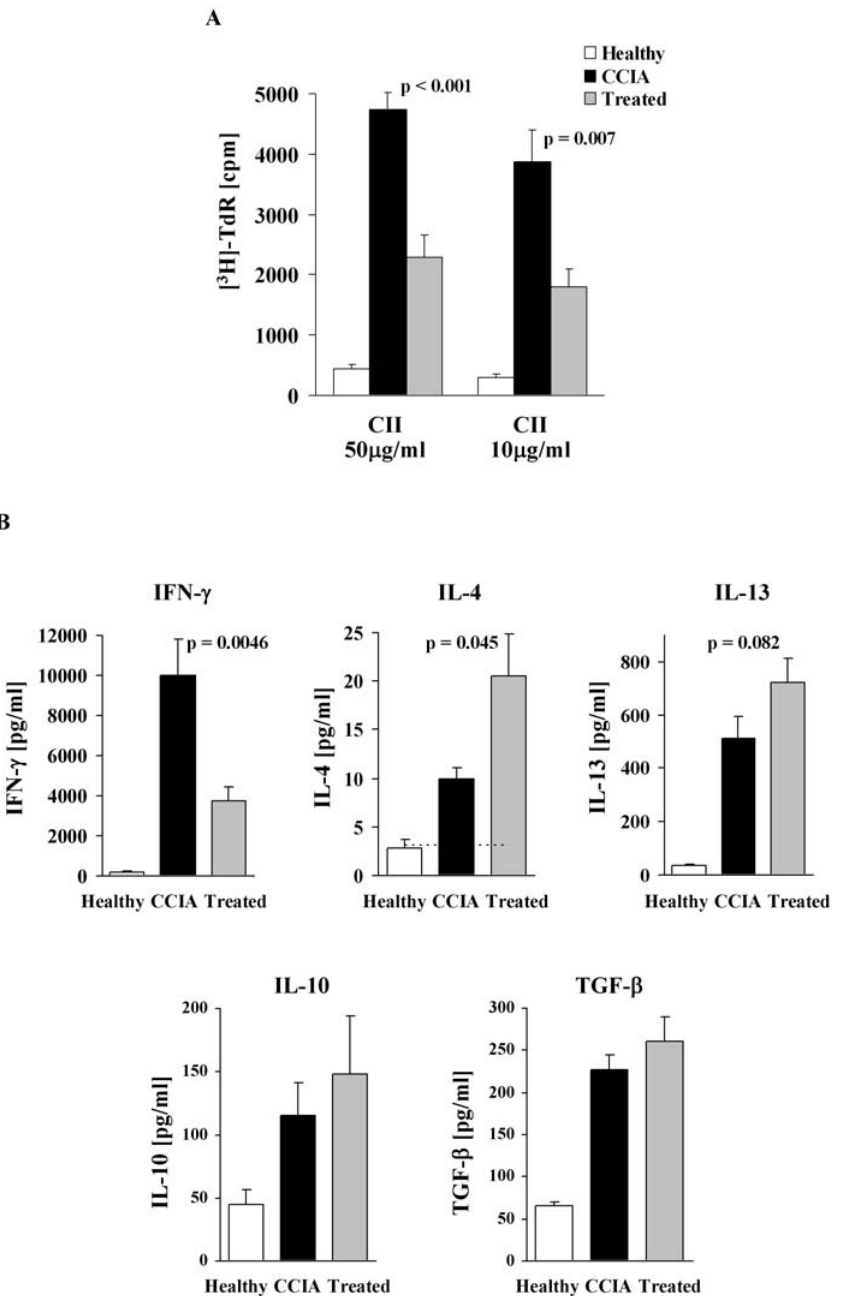
Figure 8. Treatment with epicutaneous immunization reduces CII-driven proliferation and IFN- c production while IL-4 production is enhanced. Splenocytes were collected from all mice on day 49 after induction of disease and cultured with CII or control antigen for 90 h. CII-driven proliferation (A) and production of IFN- c , IL-4, IL-13, IL-10 and TGF- b (B) were assayed as described in Figure 3. Results are expressed as mean + 1 SEM (n=9). ( % )=un-immunized healthy controls, ( & )=treated with epicutaneous CII, ( & )=sham-treated CCIA controls.